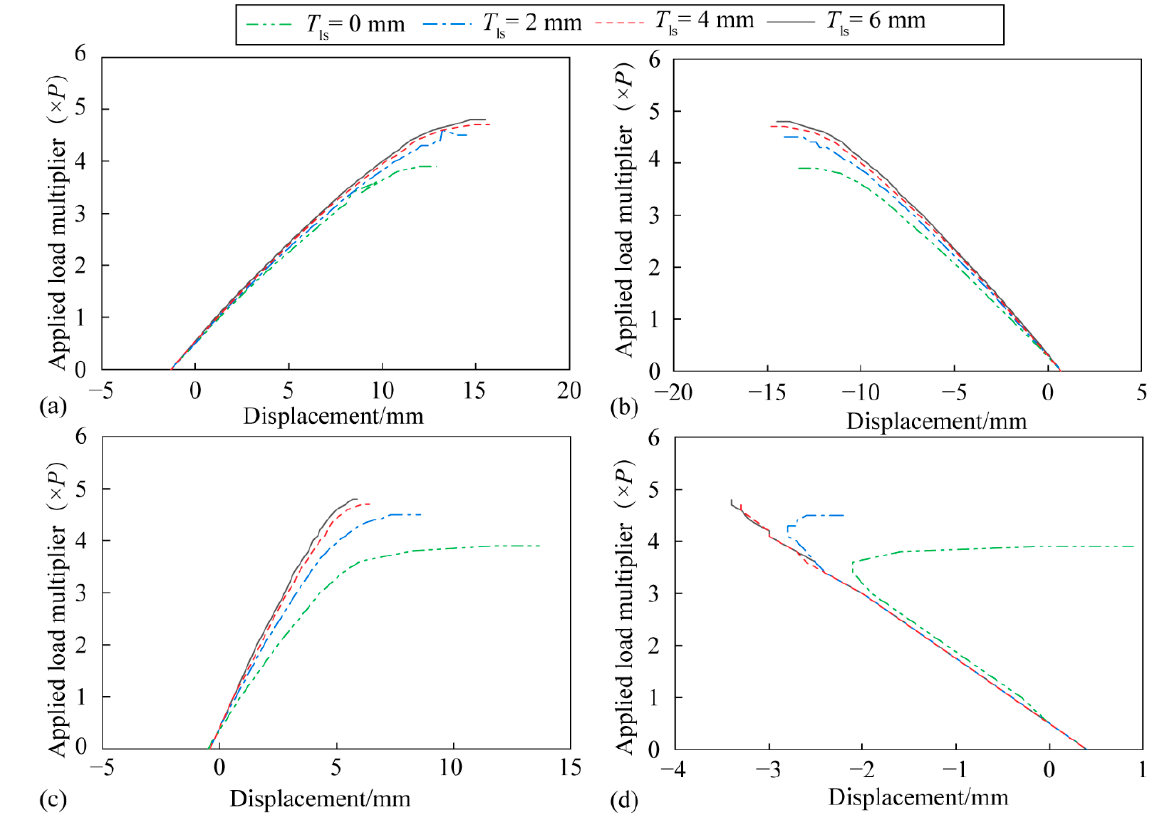
Figure 10. ( a ) Vertical displacement on the top flange, ( b ) horizontal displacement on the front web at the juncture node zone and ( c ) vertical displacement on the top flange, ( d ) horizontal displacement on the front web -in the curved location due to the change in the thickness of the longitudinal stiffening rib.